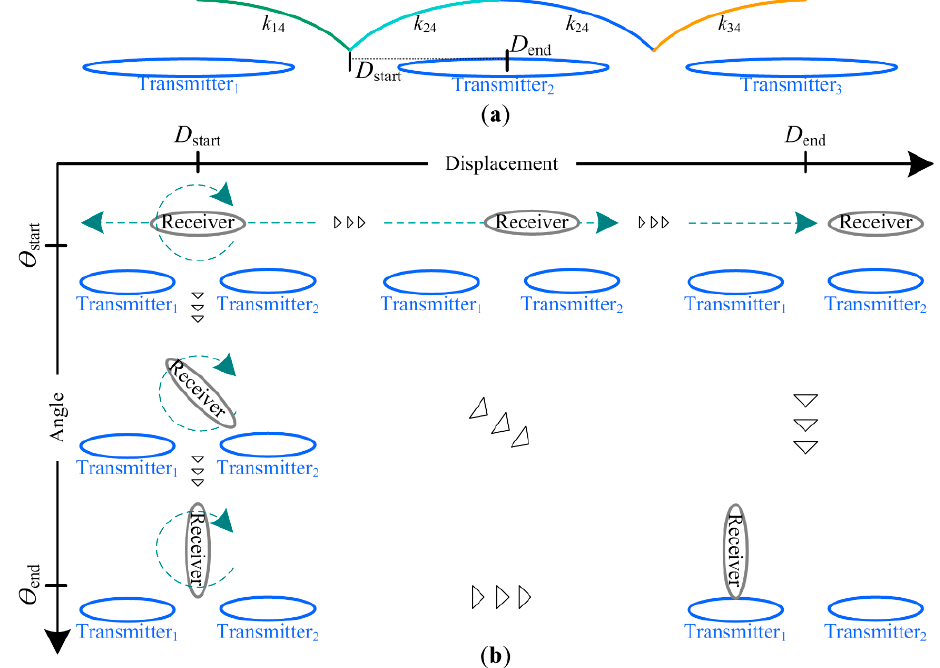
Figure 10. Estimation process of the optimal movement: ( a ) charging track and ( b ) optimization process. Table 3. Simulation parameters for the FEM